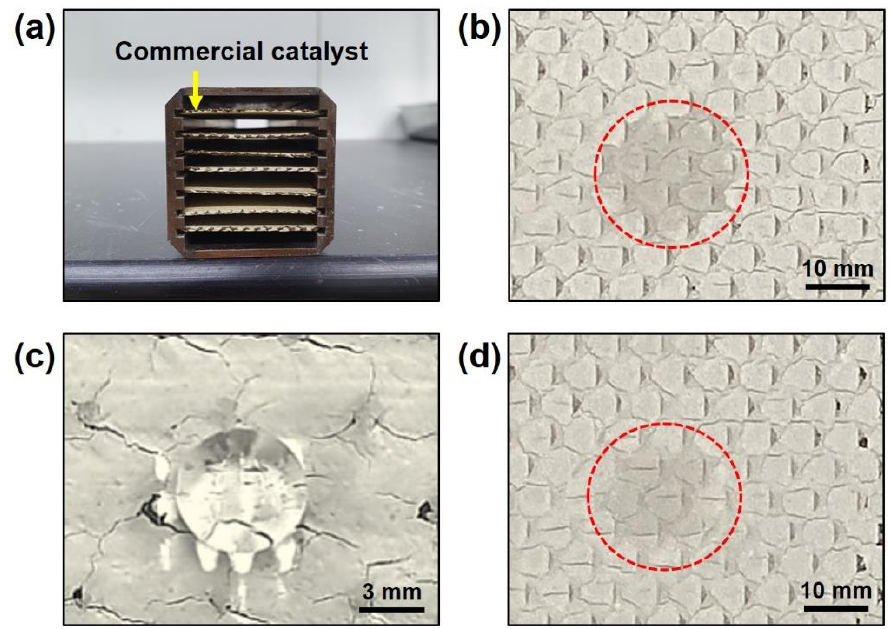
Figure 6. Microscope image of plate-type commercial catalyst ( a ), commercial catalyst surface ( b ), silanized commercial catalyst surface ( c ), and heat-treated commercial catalyst surface ( d ) after dropping water.